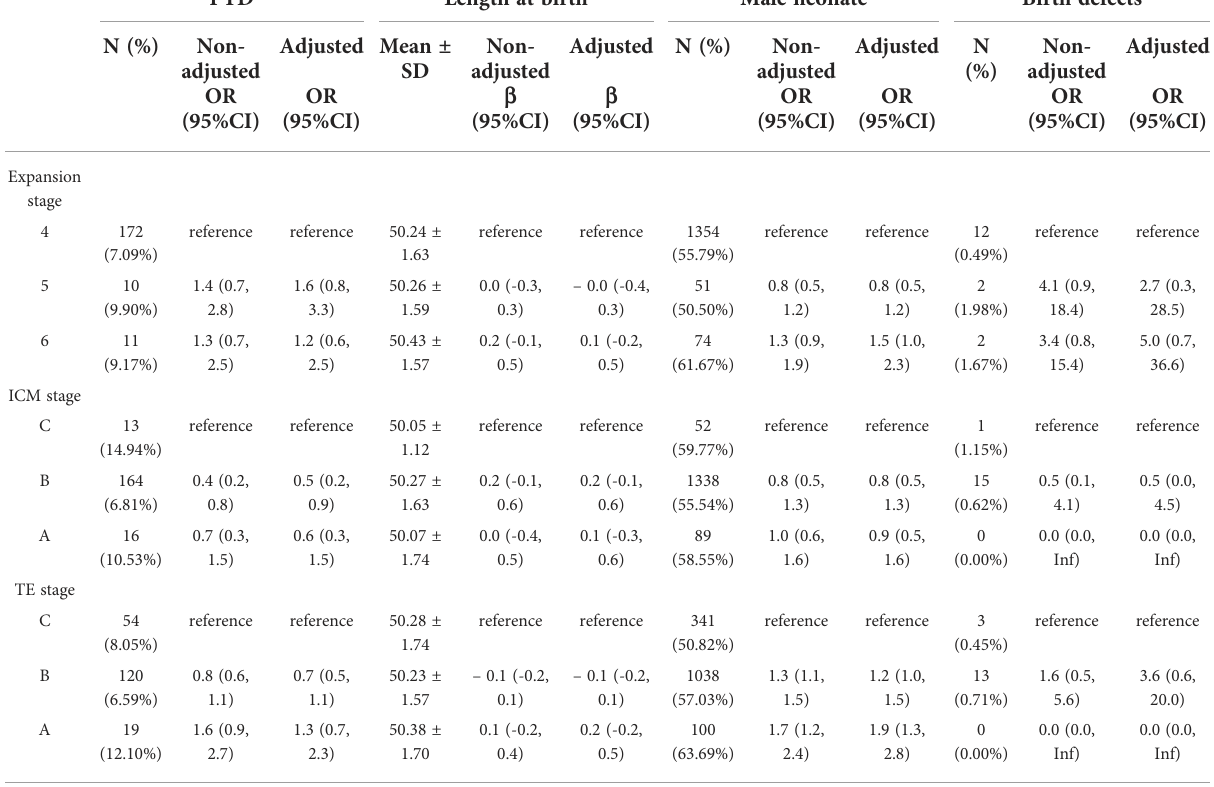
OR, odds ratio; PTD, preterm delivery. Data are expressed with mean ± SD or number (percent) as appropriate. Adjusted with female age, maternal body mass index, baseline AMH, number of 2PN, primary infertility, duration of infertility, fertilization method, transfer cycle rank, parity, FET endometrial preparation, endometrium thickness, transfer